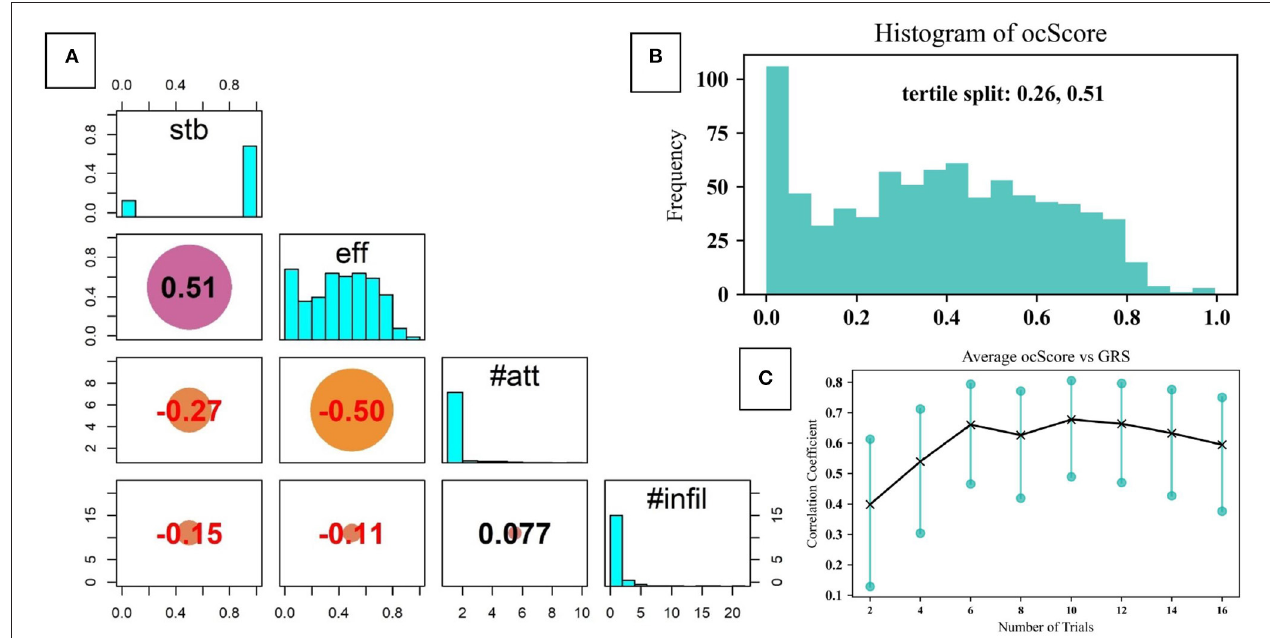
FIGURE 5 | (A) The distribution of outcome metrics and their correlation coefficients with each of the other metrics; (B) Distribution of ocScore values for all the dataset, divided into tertiles; (C) Correlation between ocScore and GRS as a function of number of trials.